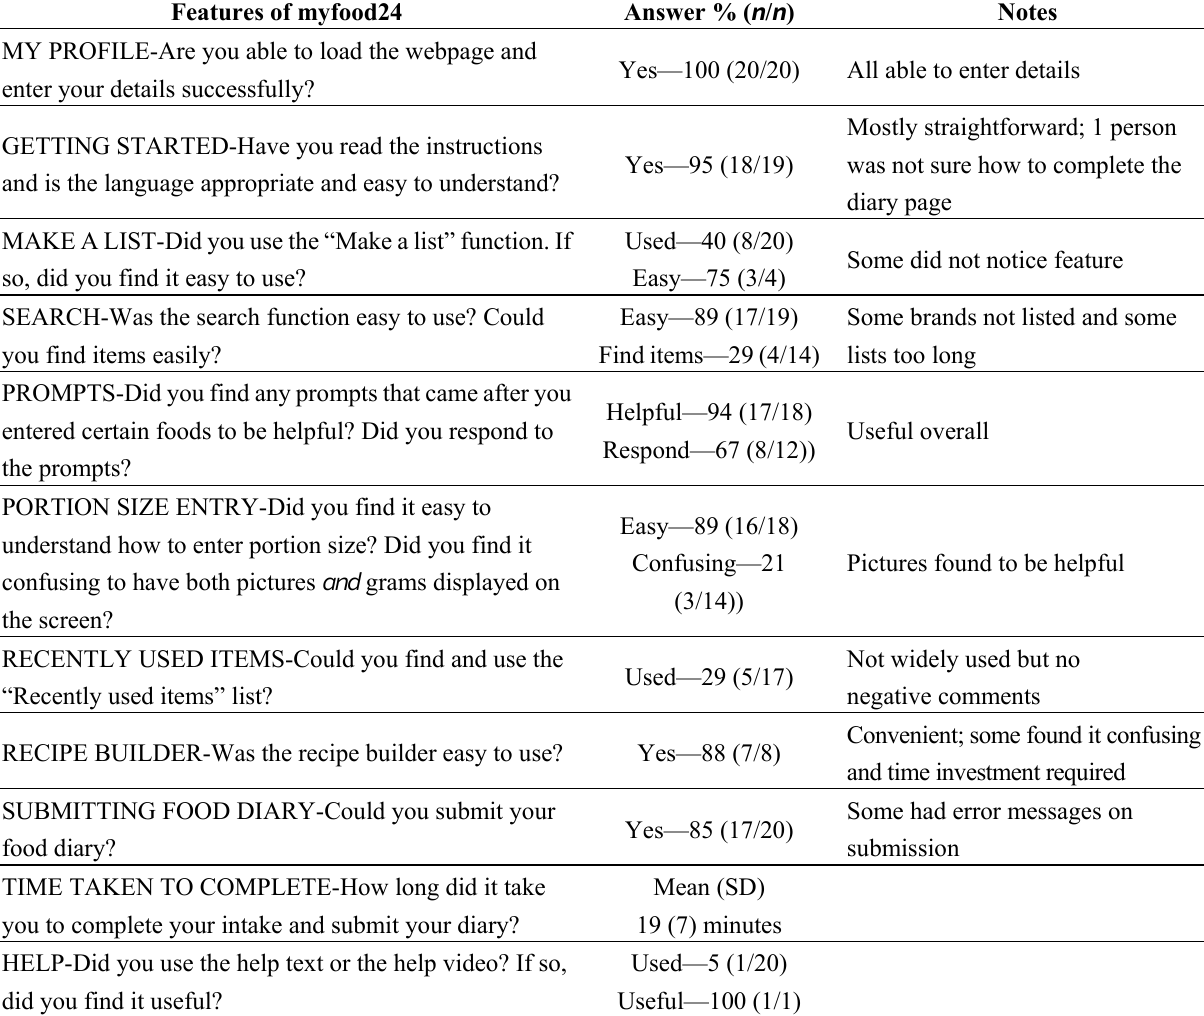
Table 5. A summary of qualitative findings relating to specific areas of the live version of myfood24 with a sample of adult